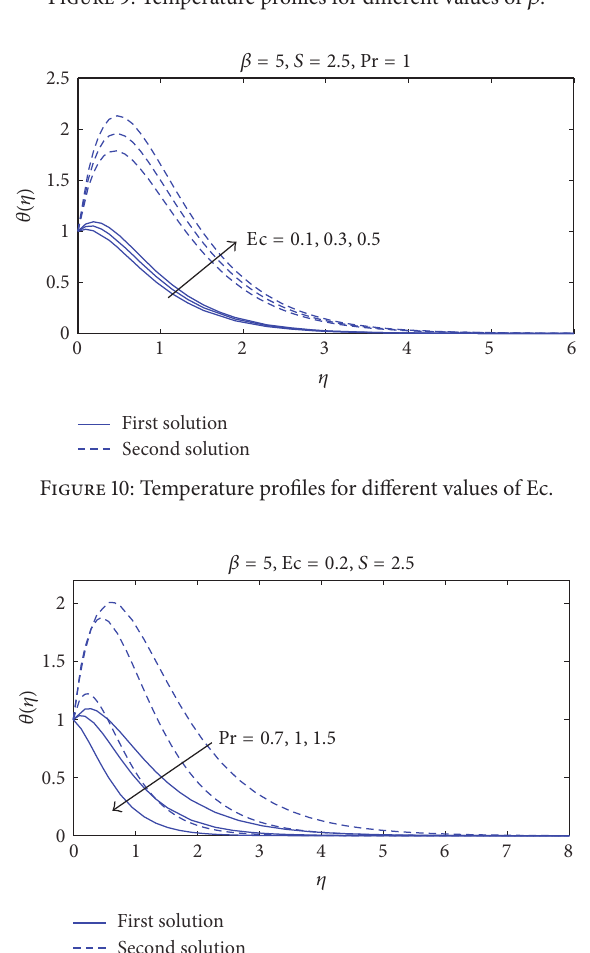
Figure 12: Velocity profiles for different values of 𝑆 .